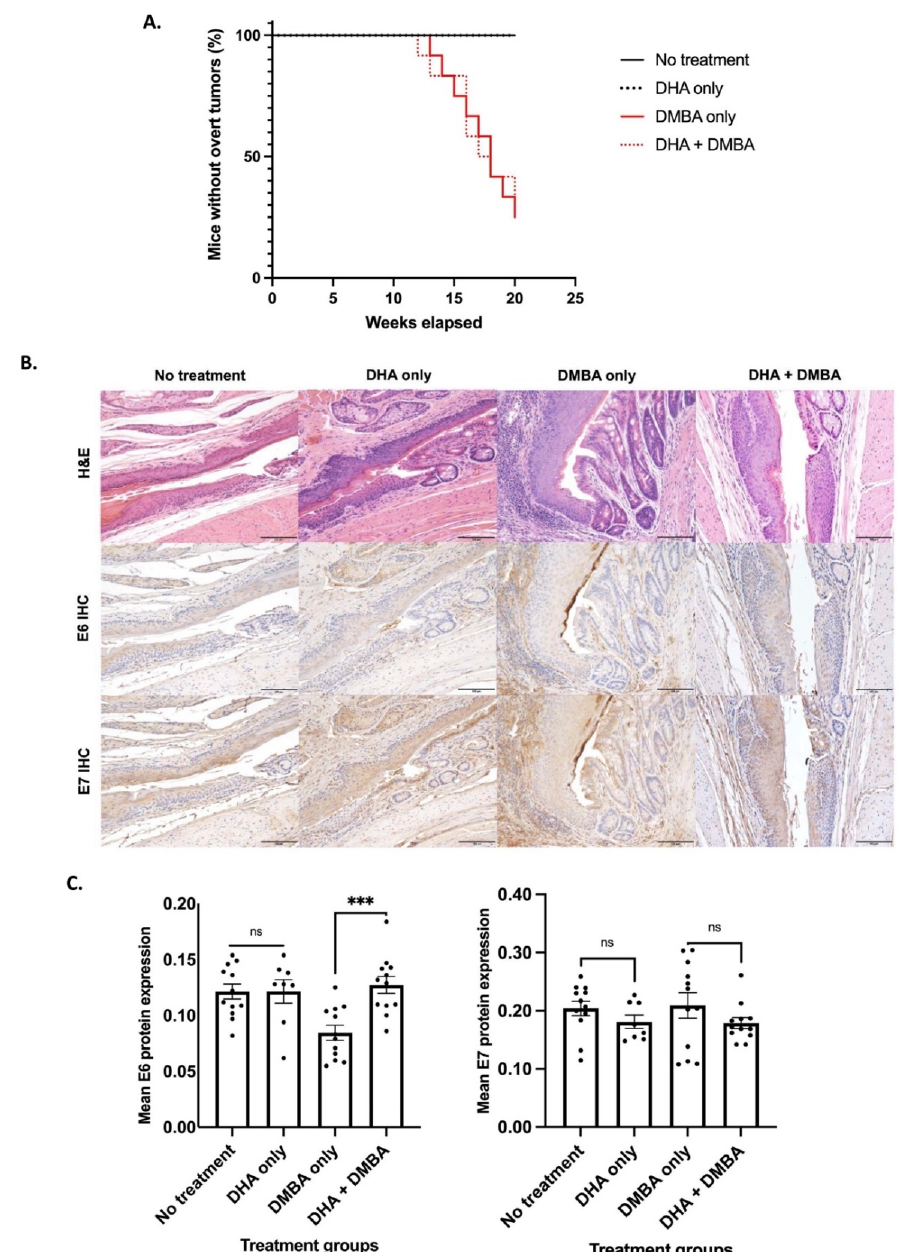
Figure 1. K14E6/E7 mice began treatment at 25 weeks of age and were either left untreated (N = 12), treated with topical DHA (N = 9), treated once weekly with topical DMBA (N = 12), or given topical DHA in conjunction with DMBA (N = 12). ( A ) DHA-treated mice with and without DMBA, as well as their respective controls, had comparable rates of tumor-free survival. ( B ) Representative images of hematoxylin-and-eosin-stained and IHC-stained anal samples for E6 and E7 K14E6/E7 from mice after completing the 20-week treatment period. All scale bars equal 100 μ m. ( C ) Mean E6 and E7 protein expression based on IHC K14E6/E7 anal tissue. Anal tissue was harvested from K14E6/E7 transgenic mice either left untreated (N = 12), treated with topical DHA (N = 9), treated once weekly with topical DMBA (N = 12), or given topical DHA in conjunction with DMBA (N = 12). Unpaired t -tests were performed to compare no treatment to DHA only and DMBA only to DHA + DMBA. Data are presented as mean ± SEM (standard error of the mean). Significance was assigned as not significant (ns), *** p <